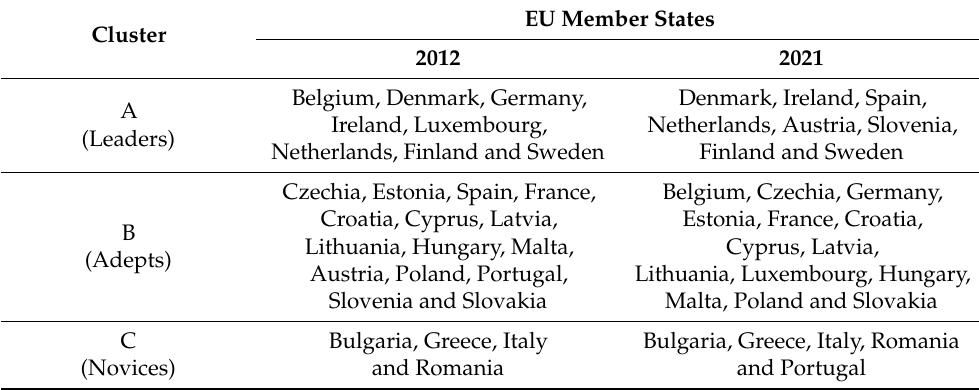
Table 10. Comparative analysis of the structure of the groups of EU states regarding the level of development of Internet purchases by individuals between 2012 and